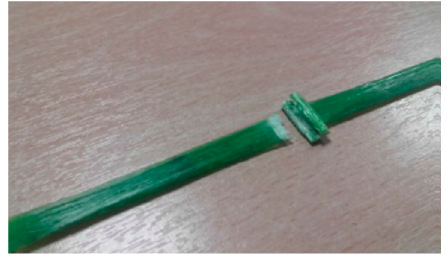
Figure 10. Partial fiber-failure at the GFRP grids joint.